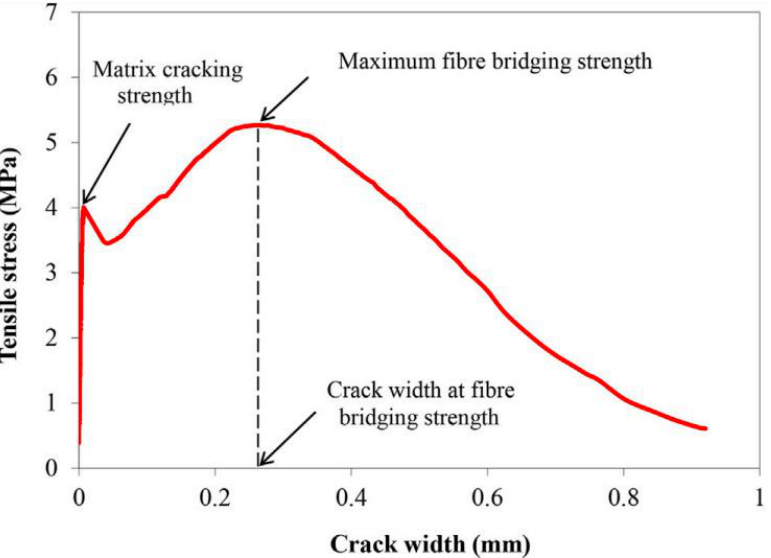
Figure 7. Fiber-bridging stress–crack opening curves of the composites obtained from uniaxial tensile tests with notched dog-bone-shaped specimens (Reprinted/adapted from Lan et al.) [7].